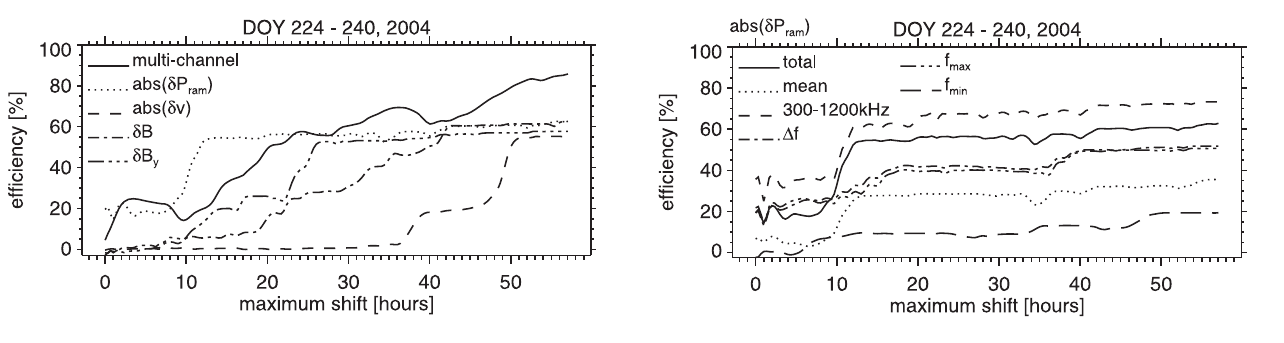
Fig. 6. The efficiency as a function of the temporal shift for the ram pressure P ram (dotted), the bulk velocity v (dashed), the magnetic field strength B (dash-dot) and the magnetic component B y (dash- dot-dot-dot). The time derivative is indicated by δ , the absolute value of the time derivative is indicated by abs(δ ) . The solid line is produced if all 4 input signals are mixed in a multi-channel filter.